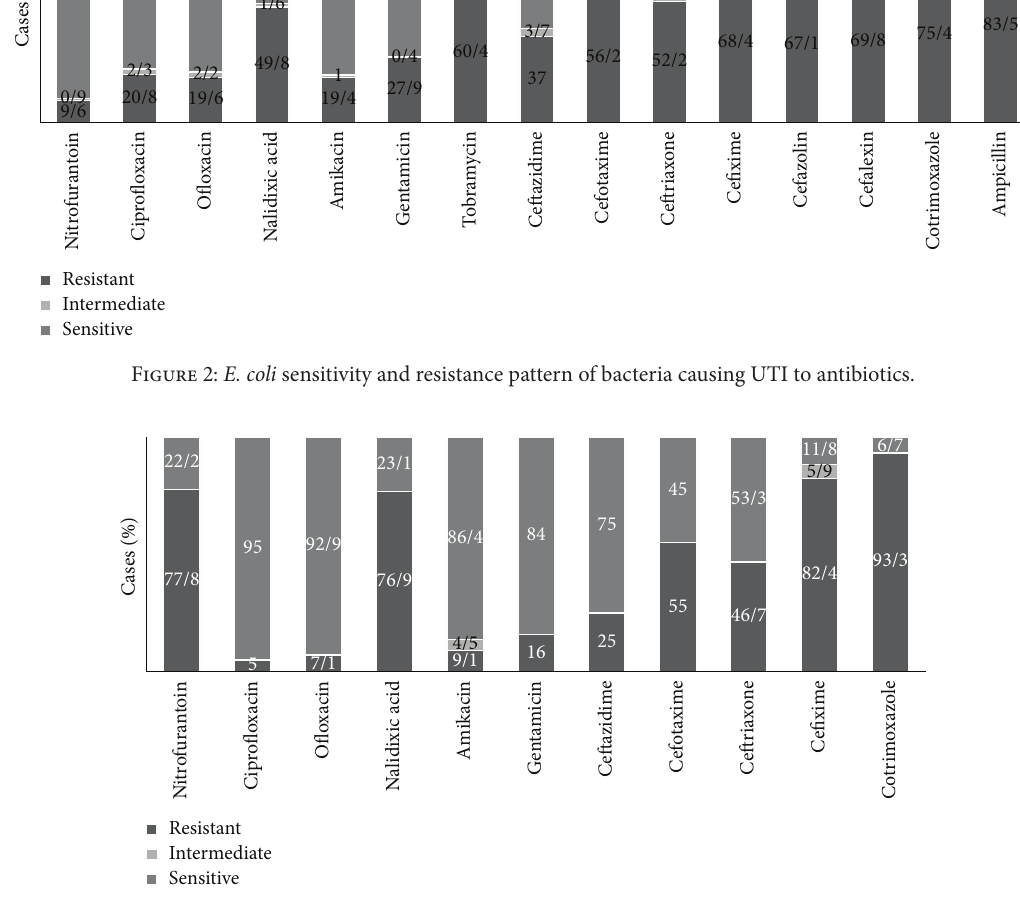
Figure 3: Pseudomonas aeruginosa sensitivity and resistance pattern of bacteria causing UTI to antibiotics.